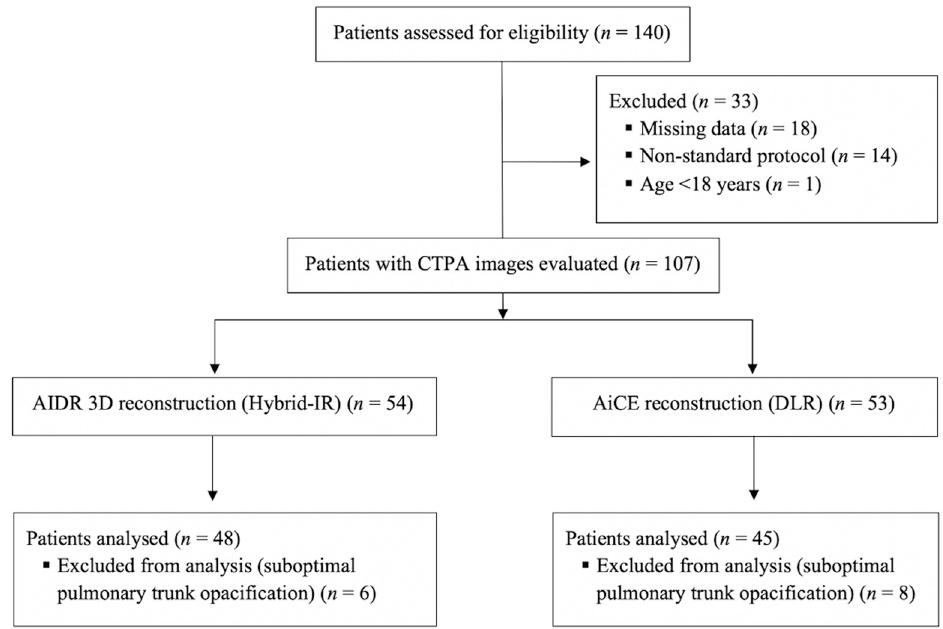
Figure 3. Flow chart of the study. CTPA, computed tomography pulmonary angiography, IR, iterative reconstruction; DLR, deep learning reconstruction; CT, computed tomography; AIDR 3D, adaptive iterative dose reduction three dimensional; AiCE, advanced intelligent clear-IQ engine; n , number.